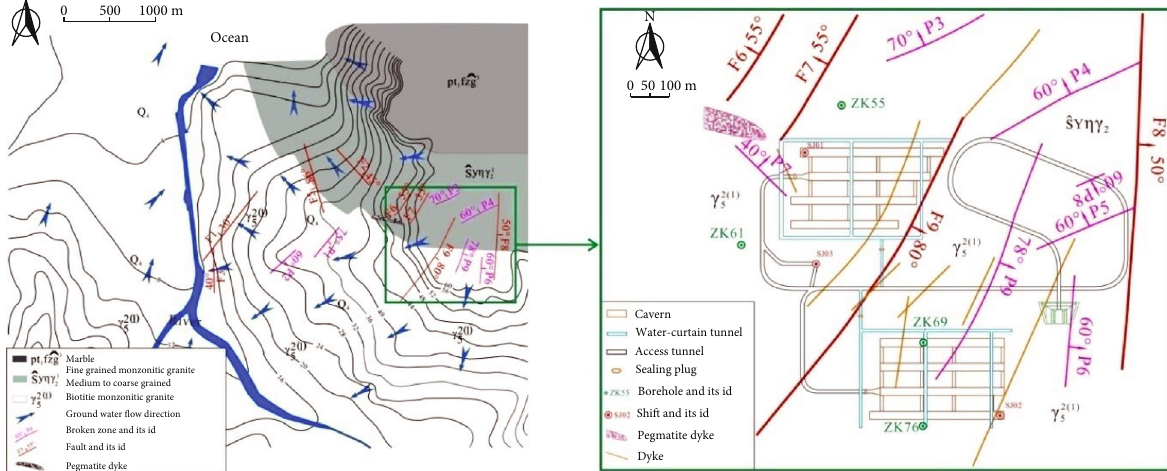
Figure 1: Geological and hydrogeological setting: (a) the regional area and (b) the study